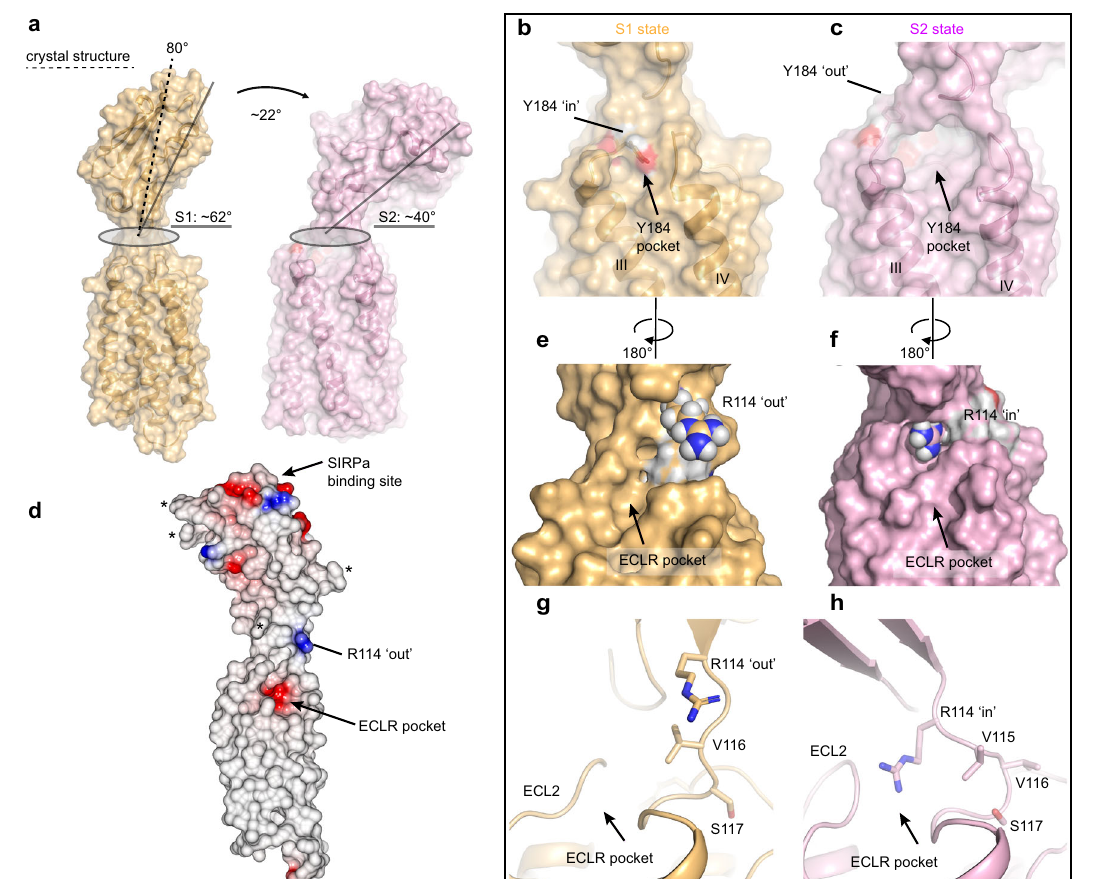
Fig. 7 Snapshots of full-length CD47 in s1 and s2 macrostates. a Surface representation of full-length CD47 models with ECD orientations corresponding to the average s1 (yellow) and s2 (light pink) macrostates with respect to the TMD. Differences in ECD tilt angle between s1 and s2 are indicated by black solid lines and labeled. A dotted black line indicates the ECD angle with respect to the TMD observed in the CD47 BRIL -B6H12 crystal structure. b – c Side-by- side comparison of the Y184 large pocket between ECL1 and ECL2 showing the position of Y184 side chain in the average s1 macrostate (Y184 ‘ in ’ position) and in the average s2 macrostate (Y184 ‘ out ’ position). d Surface electrostatic potential representation of CD47 BRIL -B6H12 crystal structure (B6H12 atoms omitted) indicating the negatively charged ECLR pocket between helix I and V, the position of R114, and the SIRP α binding site on the ECD. Asterisks indicate the position of the N-linked glycosylation sites. e – f Side-by-side comparison of R114 side chain in the average s1 macrostate (R114 ‘ out ’ position) and in the average s2 macrostate (R114 ‘ in ’ position) and movement of the R114 into the negatively charged ECLR pocket. g – h A cartoon representation of ( e ) and ( h ) showing the conformational rearrangement of the 114 RVVSWF 119 linker during molecular dynamics simulations. The side chain of residues are shown as